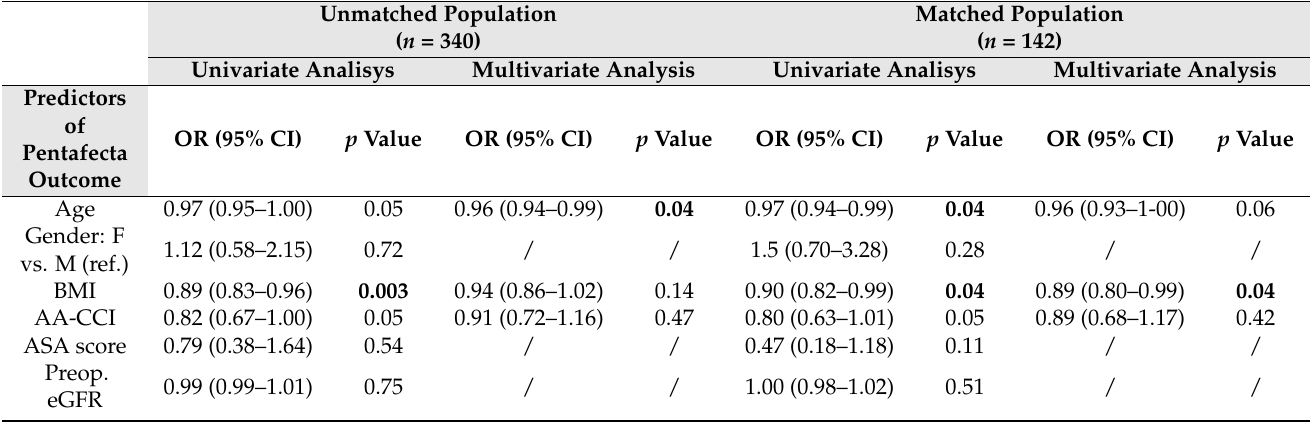
Table 3. Results for secondary outcome: univariate and multivariate logistic regressions for predictors of achieving the pentafecta